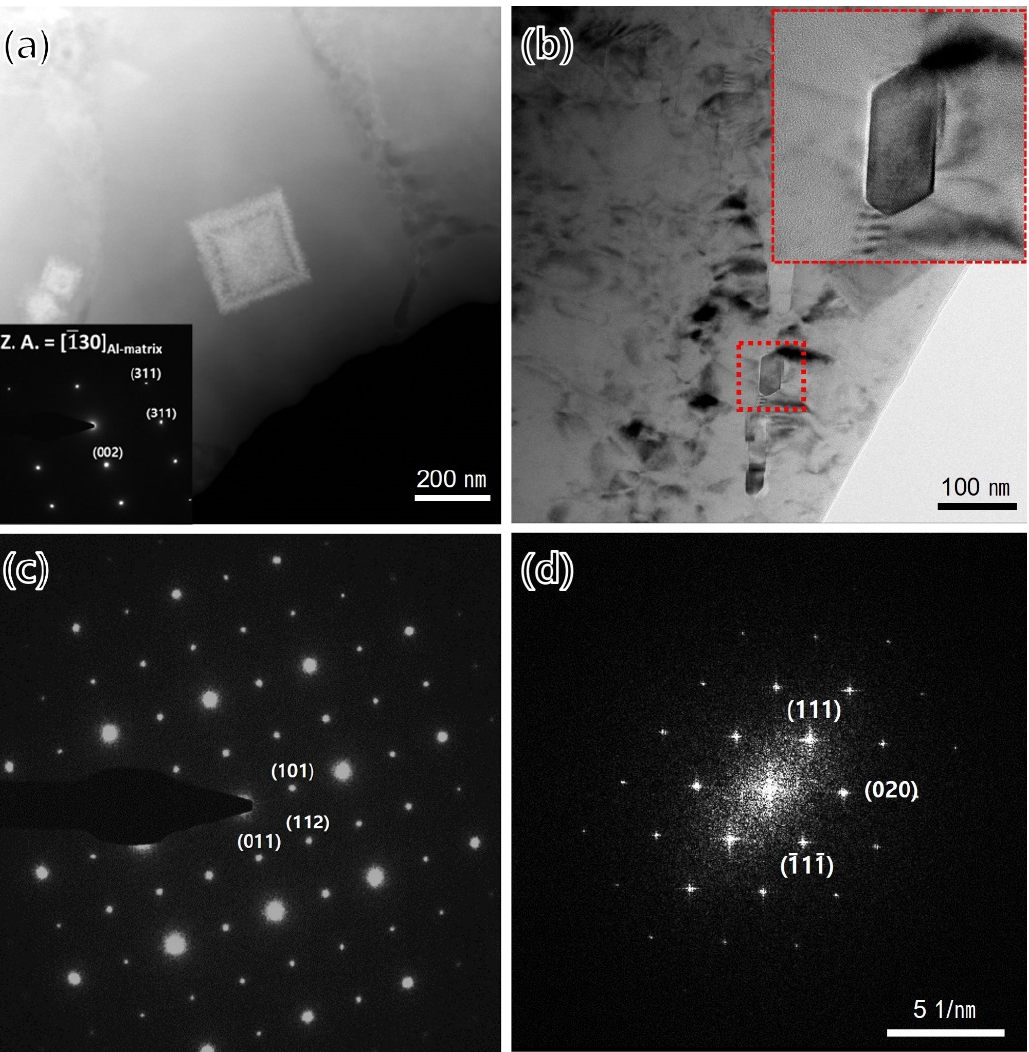
Figure 7. BF-TEM images using the STEM mode and corresponding selected area diffraction (SAD) pattern in the fine-grain region: ( a , c ) Al 3 Zr and ( b , d ) Mg 2 Si precipitates.